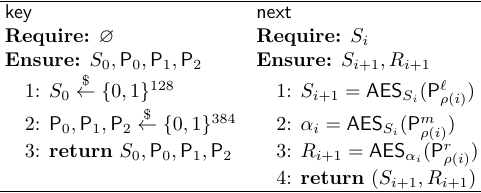
Figure 8: LPR ( f ): Construction from [LMO +